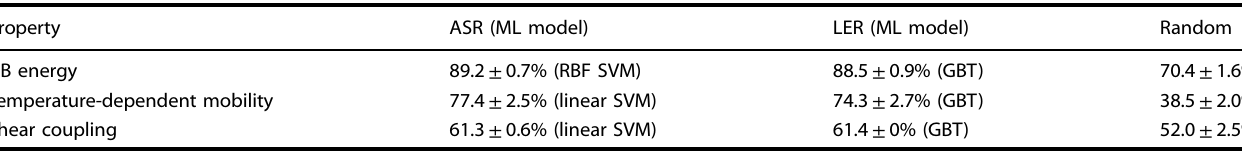
The models were trained on 50% (194) of the available 388 GBs and then validated on the remaining 194 GBs that the model had never seen. Percent error is relative to the mean. Error bars represent the standard deviation over 50 independent, random samplings (including different combinations of the 50% split), and re- fi ts of the data set. For the random column, energies were guessed by drawing values from a normal distribution that had the same mean and standard deviation as the 50% training data, and then compared to the actual energies in the validation data. For the classi fi cation problems, random choices from